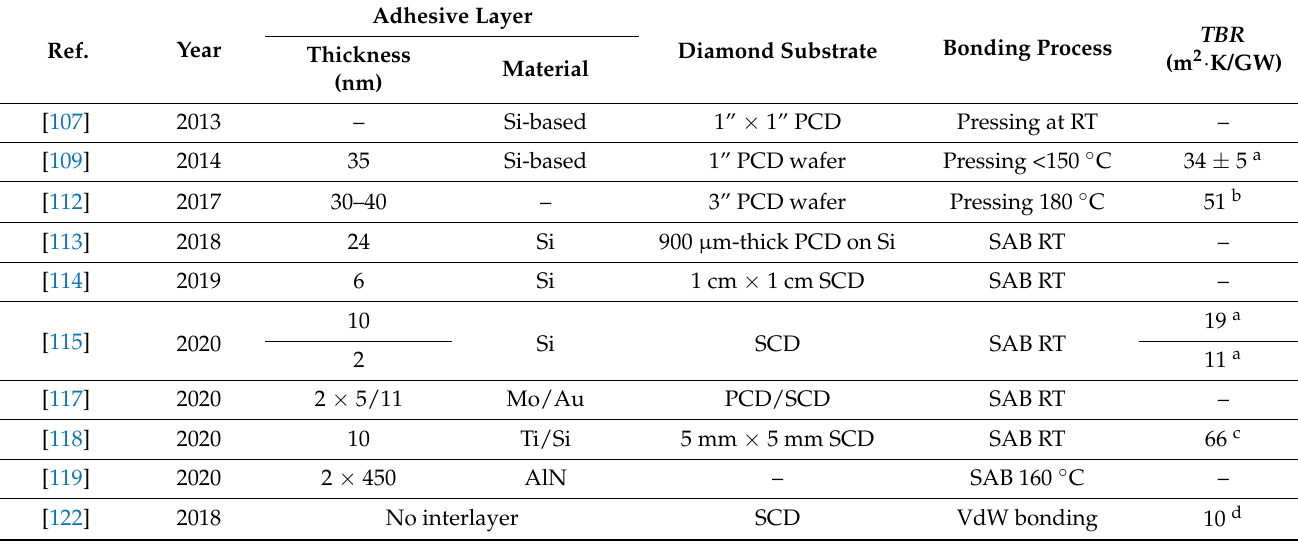
Table 4. Evolution of GaN/diamond bonded wafers